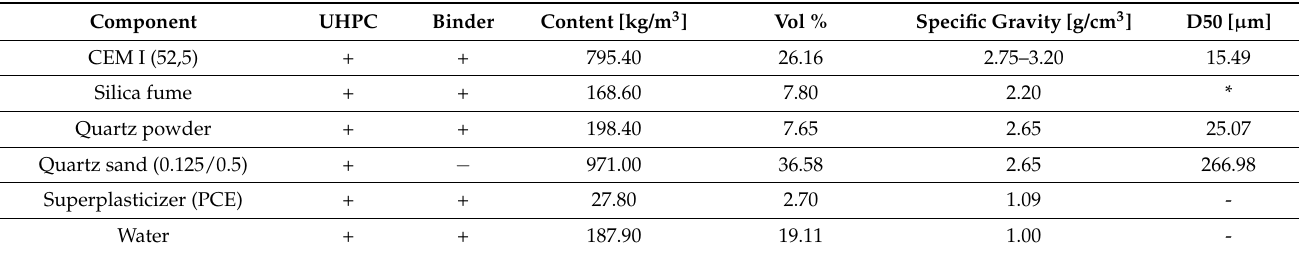
Table 1. Composition for UHPC and binder and physical properties of individual